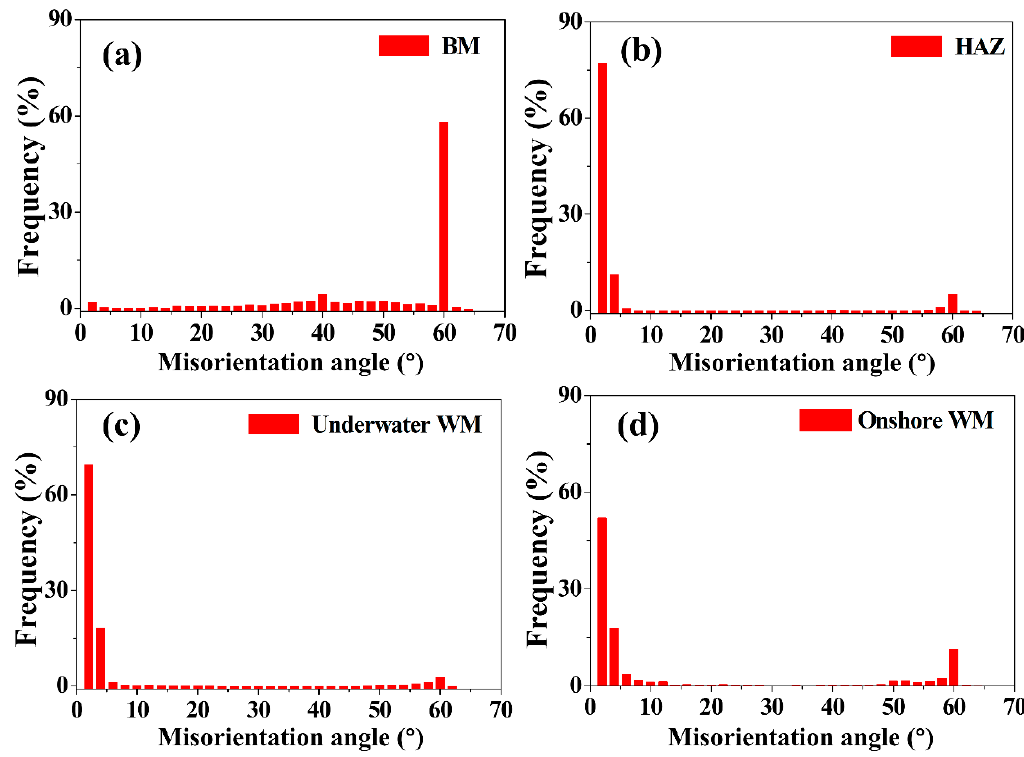
Figure 9. GBMAD of austenite for the ( a ) BM, ( b ) HAZ, ( c ) underwater WM, and ( d ) onshore WM.